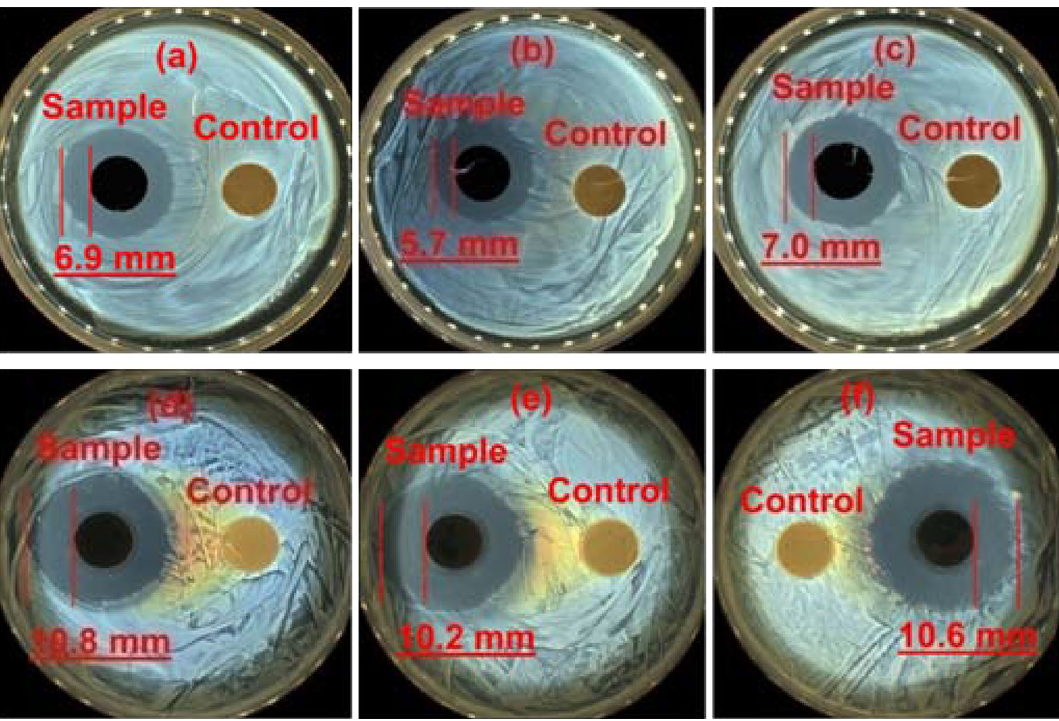
Figure 7. Antibacterial activities of samples synthesized with different concentrations of ( a , d ) ZnCl 2 (65% w/w); ( b , c , e , f ) ZnCl 2 (70% w/w); ( a , b , d , e ) 0.05 g/0.05 g (samples/MCC); ( c , f ) 0.10 g/0.10 g (samples/MCC); ( a – c ) for E. coli ; ( d – f ) for S. aureus . (The pictures were taken by ourselves during the antibacterial experiments).